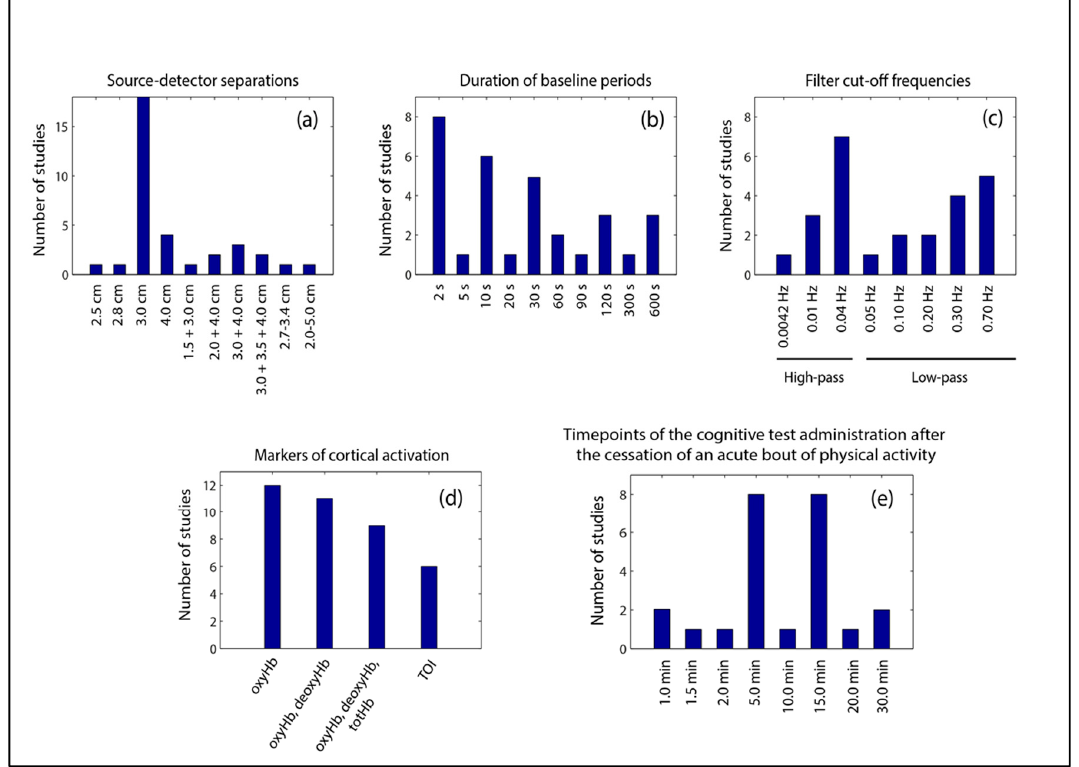
Figure 4. Overview on (a) source-detector separations, (b) durations of baseline periods, (c) filter cut-off frequencies, (d) markers of cortical activation, and (e) timepoints of the cognitive test administration after the cessation of an acute bout of physical activity. cm: centimeters; deoxyHb: deoxygenated hemoglobin; Hz: Hertz; min: minutes; oxyHb: oxygenated hemoglobin; s: seconds; TOI: tissue oxygenation index; totHb: total hemoglobin.